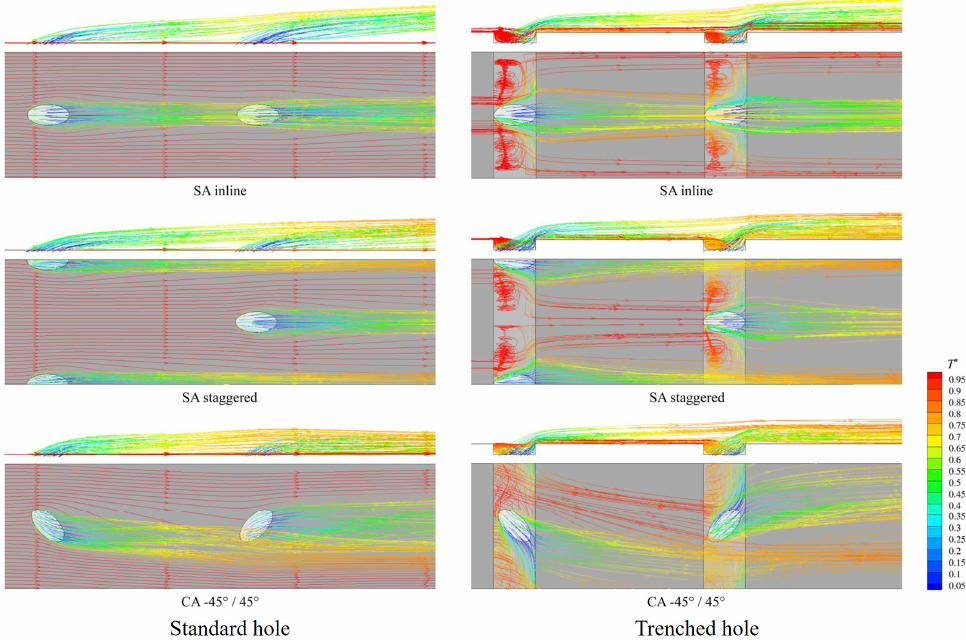
Figure 12. Streamlines colored by the dimensionless temperature for various effusion cooling con- figurations. Reprinted with permission from [88]. Licensed under a Creative Commons Attribution (CC BY) license.